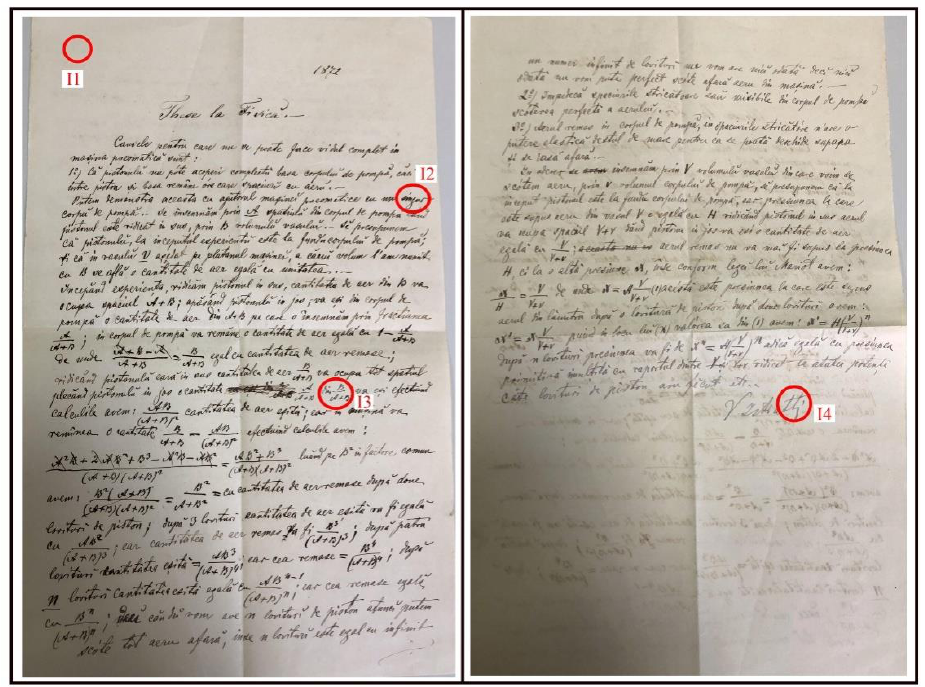
Figure 3. Student V. Istrati’s physics test—S3 and the analyzed areas (I1, I2, I3 and I4) .